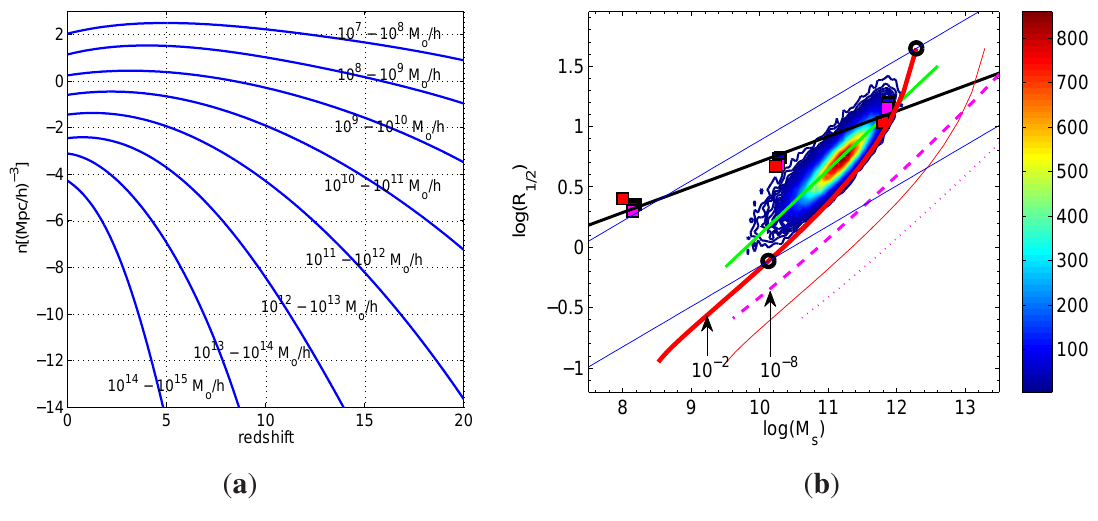
Figure 16. ( a ) The growth function of haloes n ( M , z ) , reproduced with permission DM from [122]. Copyright 2007 IOP Publishing. ( b ) The cosmic galaxy shepherd (CGS) and the corresponding locus of DM parent haloes (the red thick and thin solid lines, respectively) on 2 haloes per (Mpc/h) 3 . For comparison, the MR-plane. The halo number density is N = 10 − h 8 haloes per (Mpc/h) 3 (the magenta thick and thin dashed we also show the case for N = 10 − h lines). The observational data is the HB sample of [227] with their linear fit (solid black line), and two theoretical MRR from Equation (6) by [232] (solid thin blue lines), relative to z = 0 and z = 10 , with m = 10 and f = 1 together with the reference galaxy models and their σ linear fit (filled squares and black solid line). Adapted from